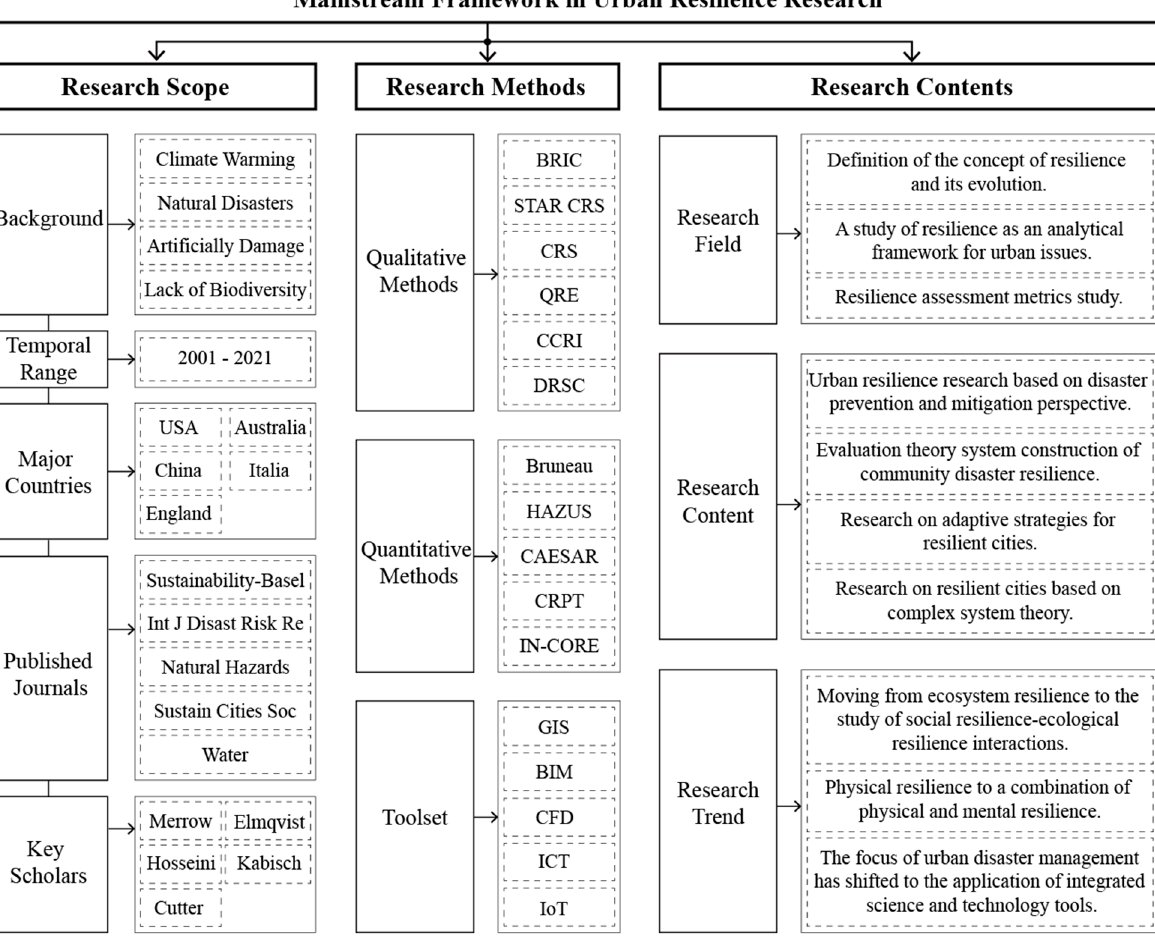
Figure 11. Mainstream framework in RC research.